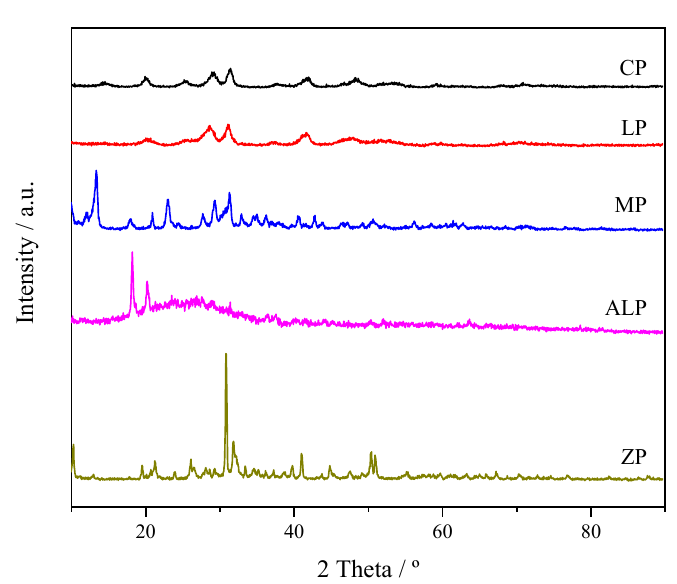
Figure 1. XRD patterns of different metal phosphate catalysts.